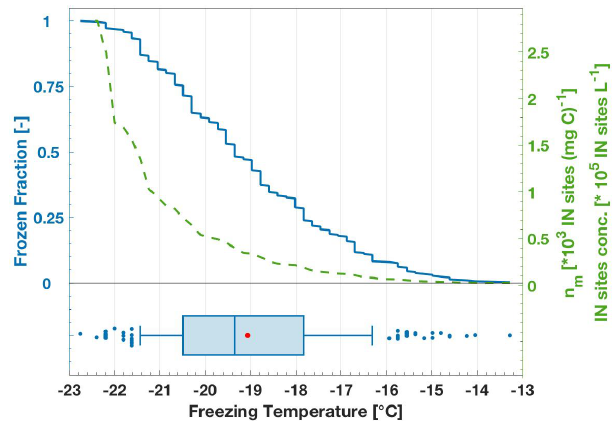
Figure 3. Example of freezing data visualization based on a 100mgCL − 1 lignin sample solution. The left blue y axis shows the FF curve as a stepwise function of each freezing event; 288 data points are included. The green line curve and the right green y axis show both the INP number concentration and n m as the INP num- ber concentration normalized to carbon content. Note that the INP concentration and n m values differ only by the factor of 100, given by the TOC concentration of 100mgCL − 1 in this example. The FF curve on top is consolidated into a boxplot at the bottom. On the boxplot, the red dot shows the mean value, and the middle blue ver- tical line shows the median ( T 50 ). The box frame is limited to the 25th and 75th percentiles and the box whiskers show the 10th and 90th percentiles. The remaining percentiles (1st–9th, 91st–100th) are shown as individual data points with filled blue